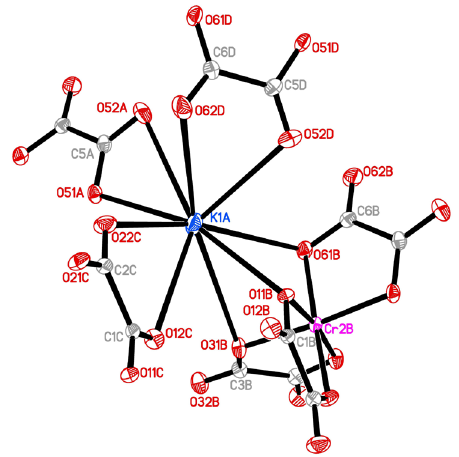
Figure 2. The nine-coordination environment of potassium in complex 1 . Atoms are displayed as gray, red, pink and blue ellipsoids for carbon, oxygen, chromium and potassium,